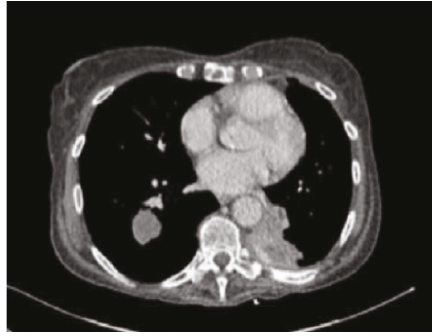
Figure 2: Restaging CT post 9 cycles of Nivolumab. There was a reduction of the RLL mass post 9 cycles of Nivolumab.